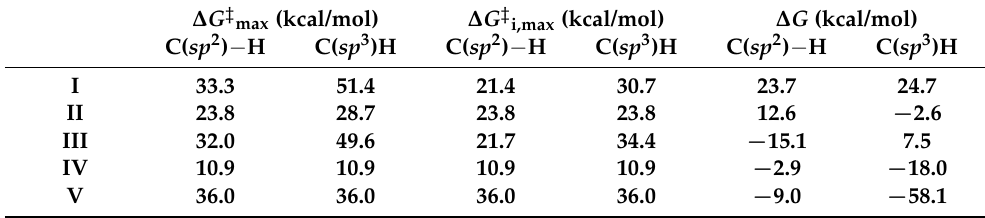
Table 1. Maximum free energy barriers ( ∆ G ‡ max ), largest free energy barrier for any individual step ( ∆ G ‡ i,max , kcal/mol), and thermodynamic free energies ( ∆ G ) of C − H activation products for the C( sp 2 ) − H and C( sp 3 ) − H activation processes.